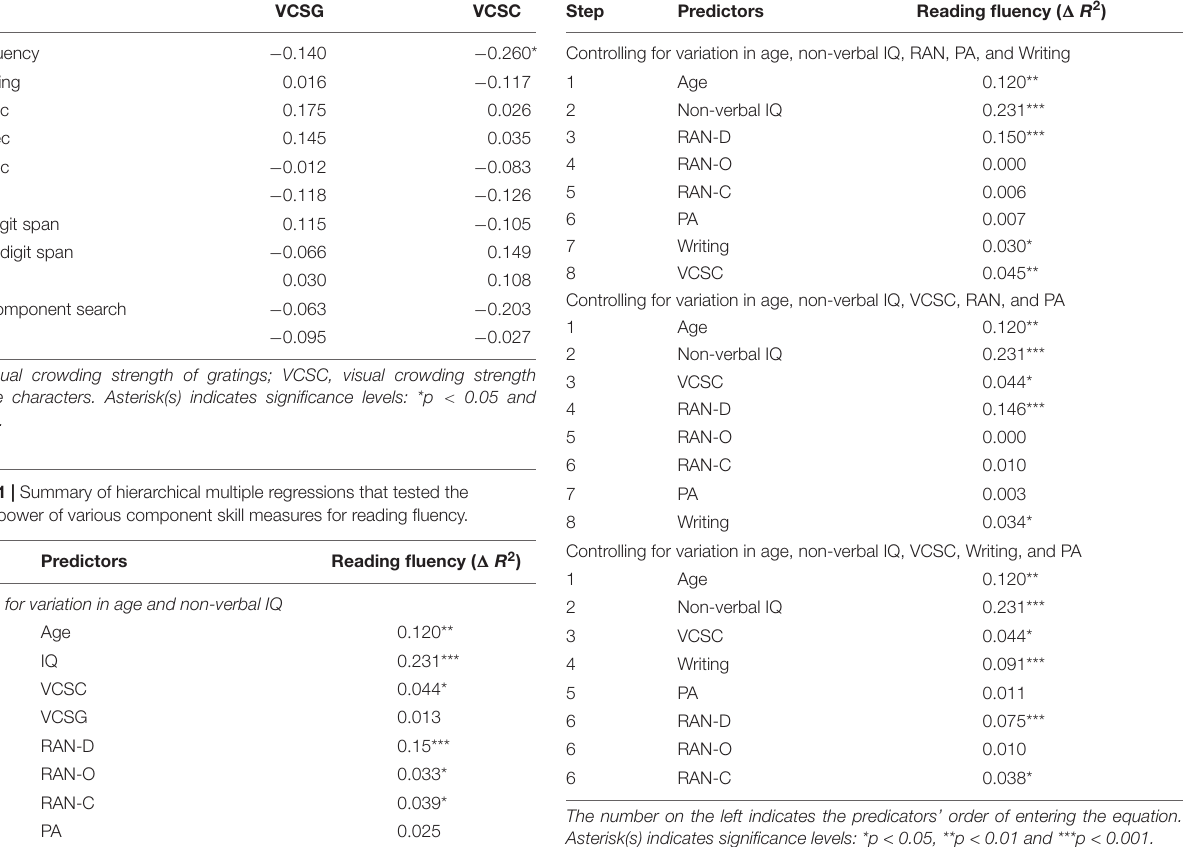
TABLE 6-2 | Summary of hierarchical multiple regressions that tested the TABLE 5 | Partial correlations between visual crowding effect and reading predictive power of visual crowding effects for reading fluency. performance and cognitive skills, controlling for age and non-verbal intelligence. VCSG VCSC Step Predictors Reading fluency ( (cid:49) R 2